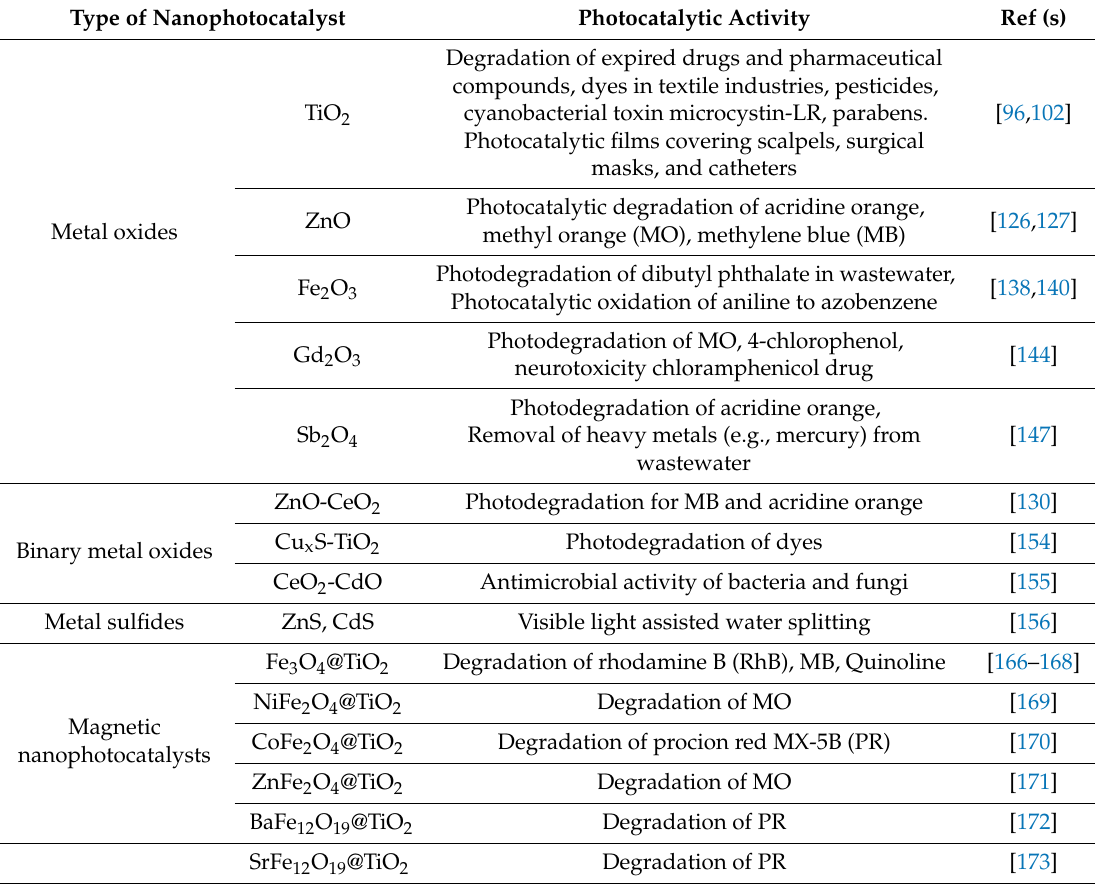
Table 3. The summary of typical applications of di ff erent types of